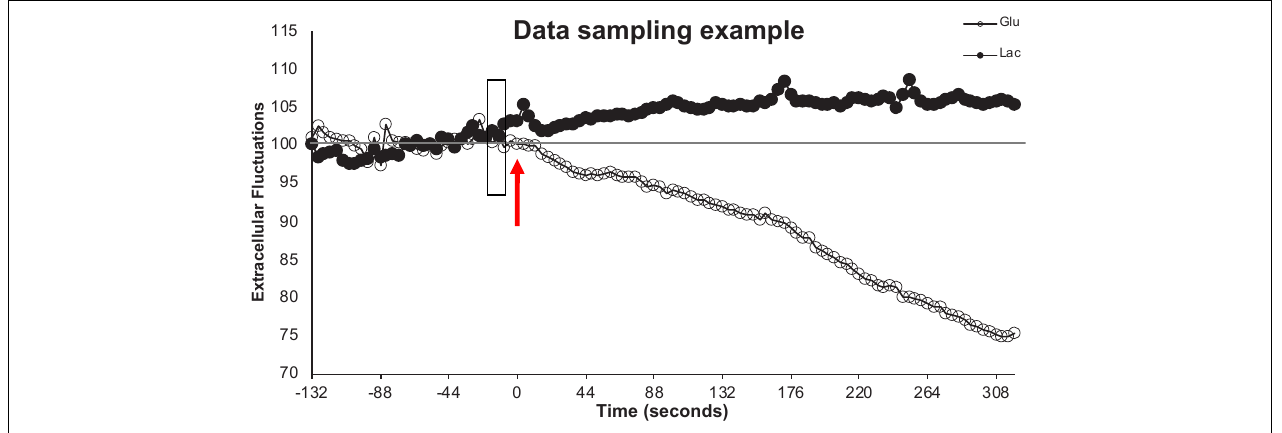
FIGURE 5 | Illustration of data sampling. This figure illustrates a single run and demonstrates the sampling stability of the electrodes prior to behavior. Time 0 and the arrow (red) represents the start of the run. The 2+ minutes of extracellular values (% from baseline) prior to the start of the run (left of the arrow) represent fluctuations in extracellular glucose (open circle) and extracellular lactate (filled circle) during normal (non-running) activity in the testing cage. These values remain close to baseline. The shaded rectangle represents the 10 s of data that is averaged to create the individualized baseline with which the relative extracellular values during this run will be calculated. The extracellular values (% from baseline) to the right the arrow represent the relative extracellular glucose and lactate values during the running behavior. To simplify the representation, data points were averaged every 4 s.